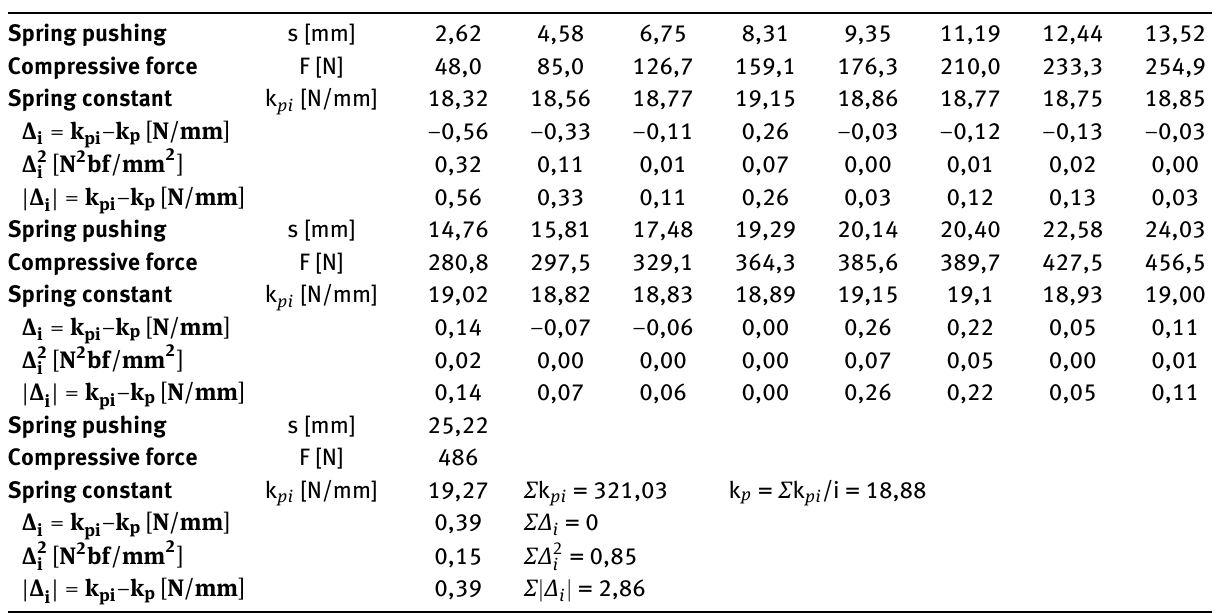
Table 2: Experimental measurement No. 2